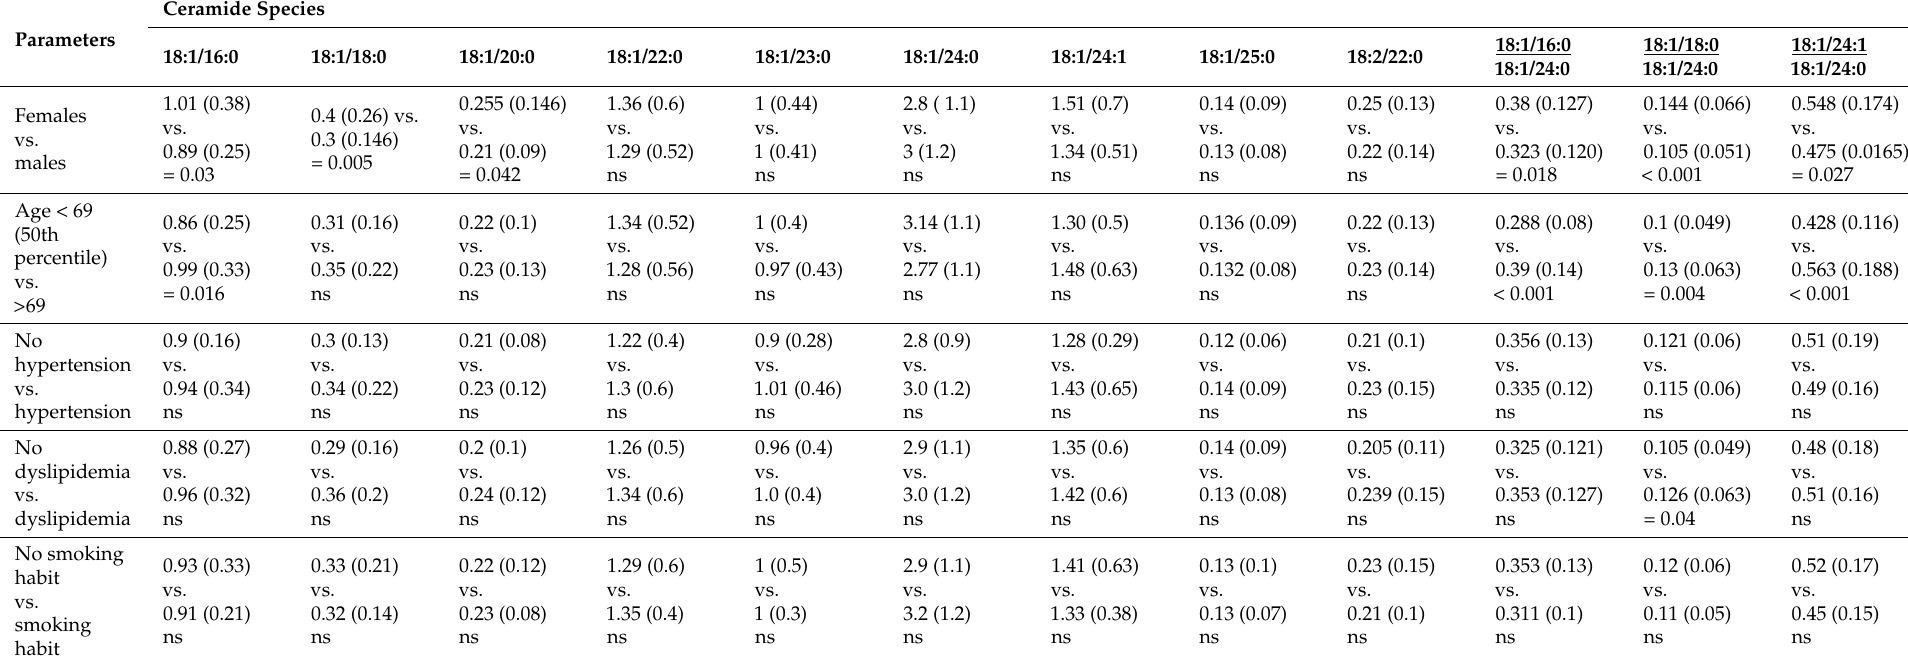
Table 3. Correlation between CV risk factor and